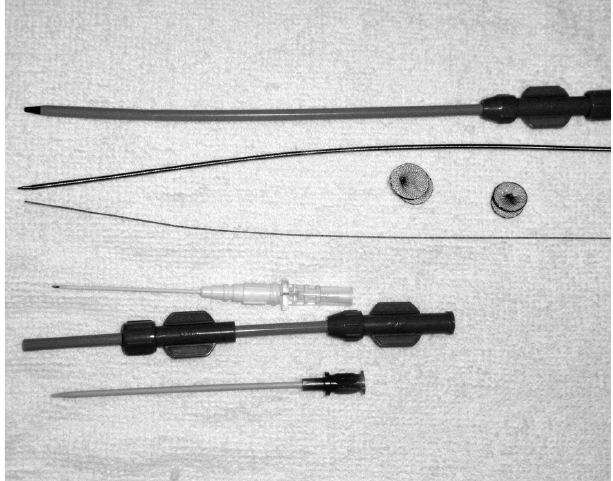
Fig. 2 – Occluder and delivery